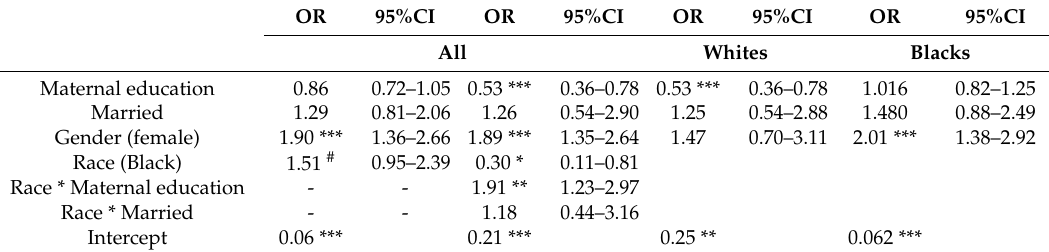
Table 5. The results of four logistic regression models in the pooled sample and across races on the combined effects of maternal education and marital status on subsequent SRH in the youths at age 15.